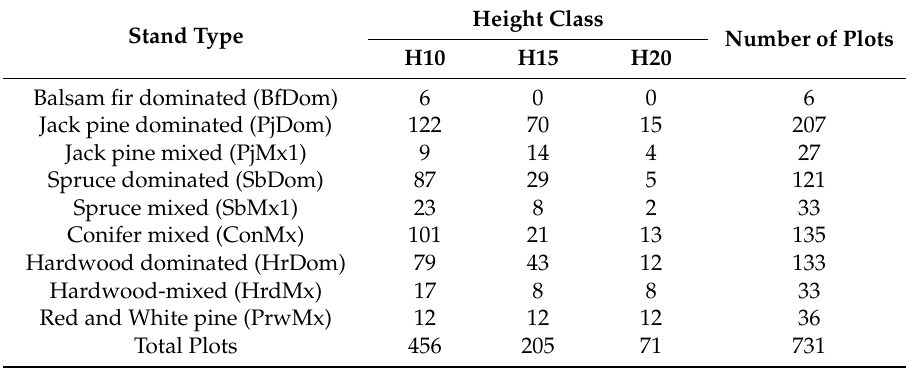
Table 2. Plot distribution by stand type and height